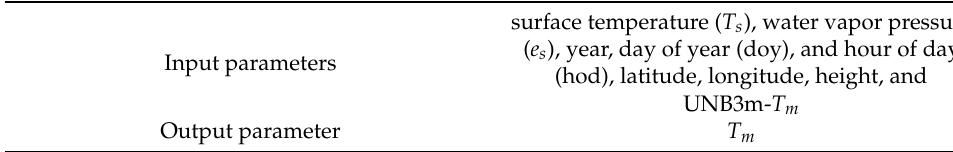
Table 1. Main features of the hybrid